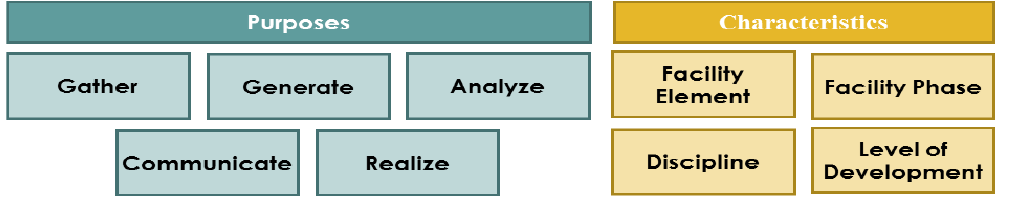
Fig. 1. The components of BIM use and characteristics (Kreider & Messner, 2013, p. 6).